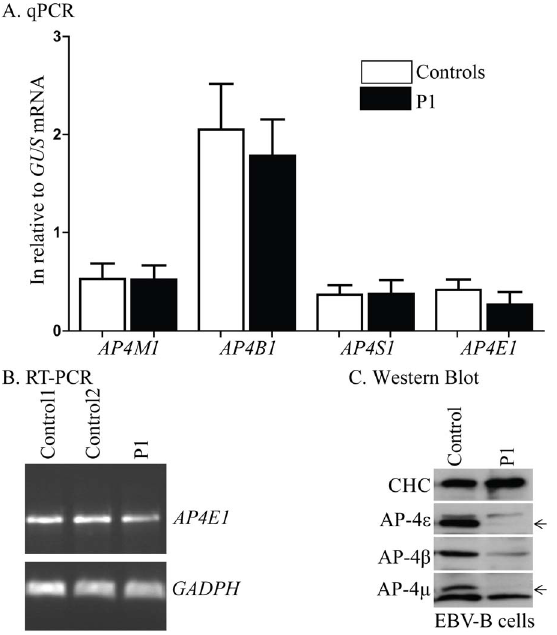
and 50 m g/ml streptomycin at 37 u C, with passaging (1:2) every three to four days.